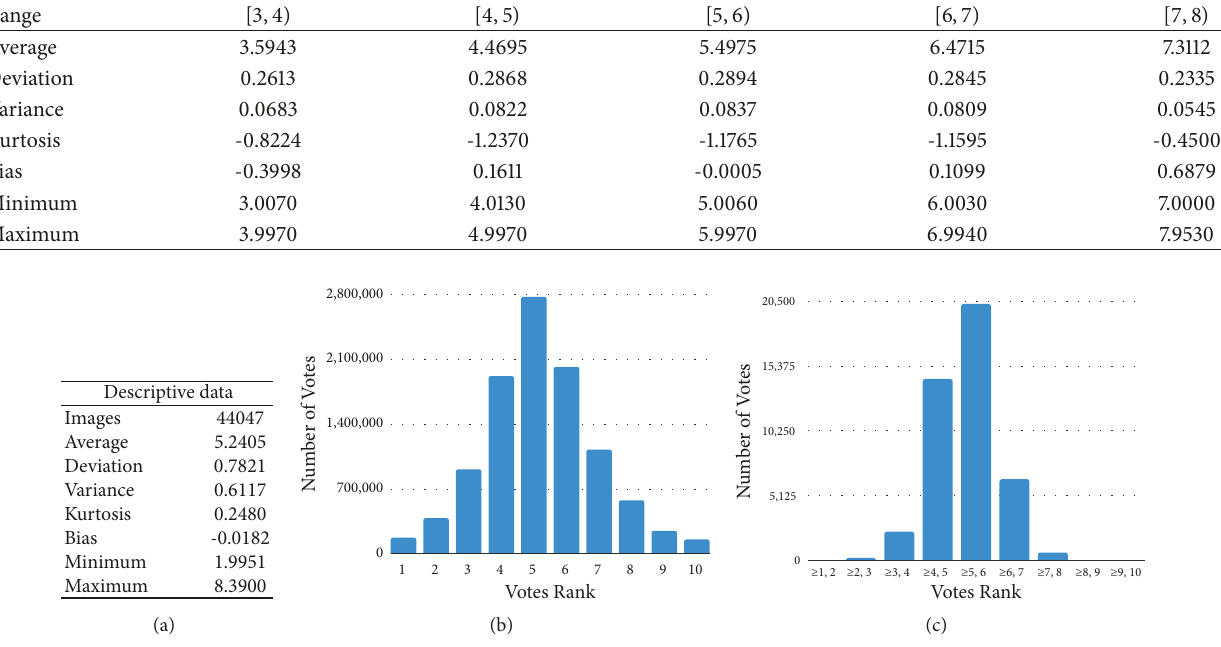
Figure 1: Characterisation of all 44,047 images initially obtained from DPChallenge. (a) Descriptive data, (b) arrangement of the number of votes within the range of valid ratings, and (c) distribution of mean image evaluations within the range of valid ratings.